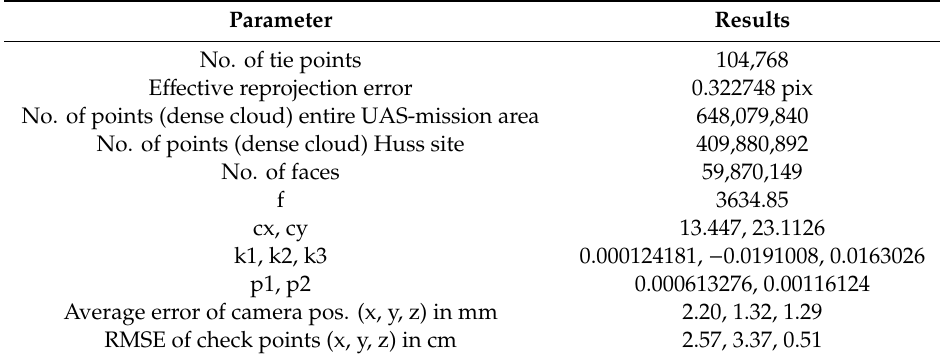
Table 4. UAS data-processing results and camera (Brown–Conrady) model